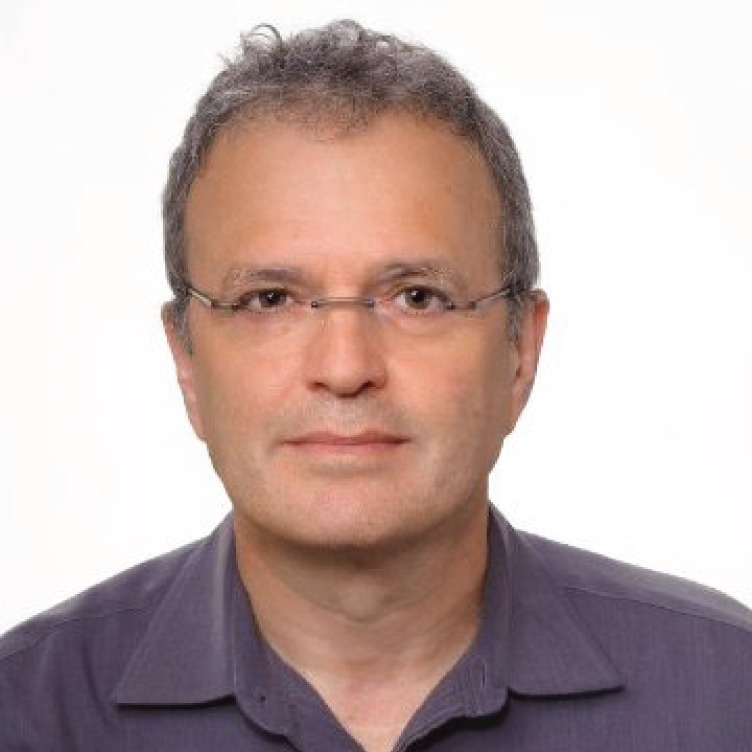
Matthew D. Breyer